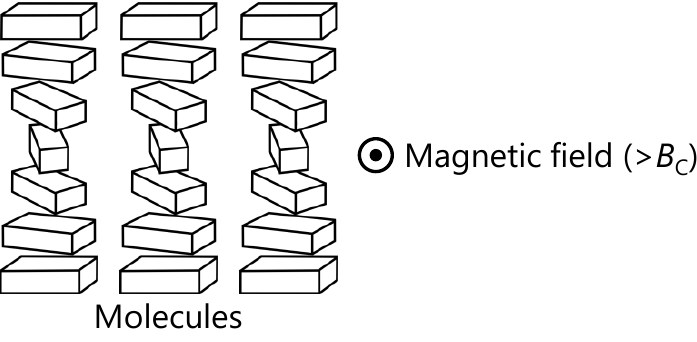
Figure 4. Schematic illustration of twist deformation of molecular alignments induced by applied magnetic field. Molecules in closer to the center reorient along to magnetic